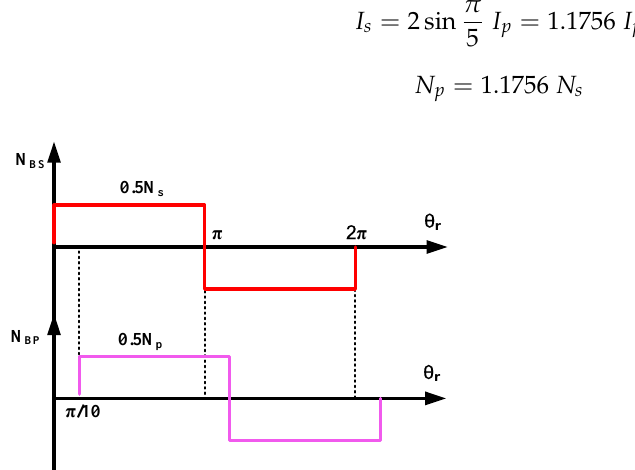
Figure 6. The winding functions for the star and pentagon windings of phase B.